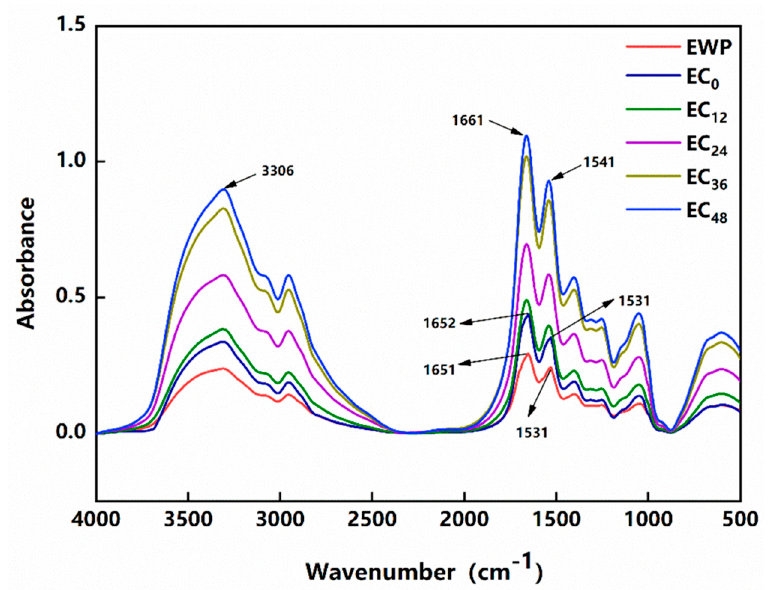
Figure 1. FTIR spectra of EWP and EWP/CMC ‐ Na conjugates.